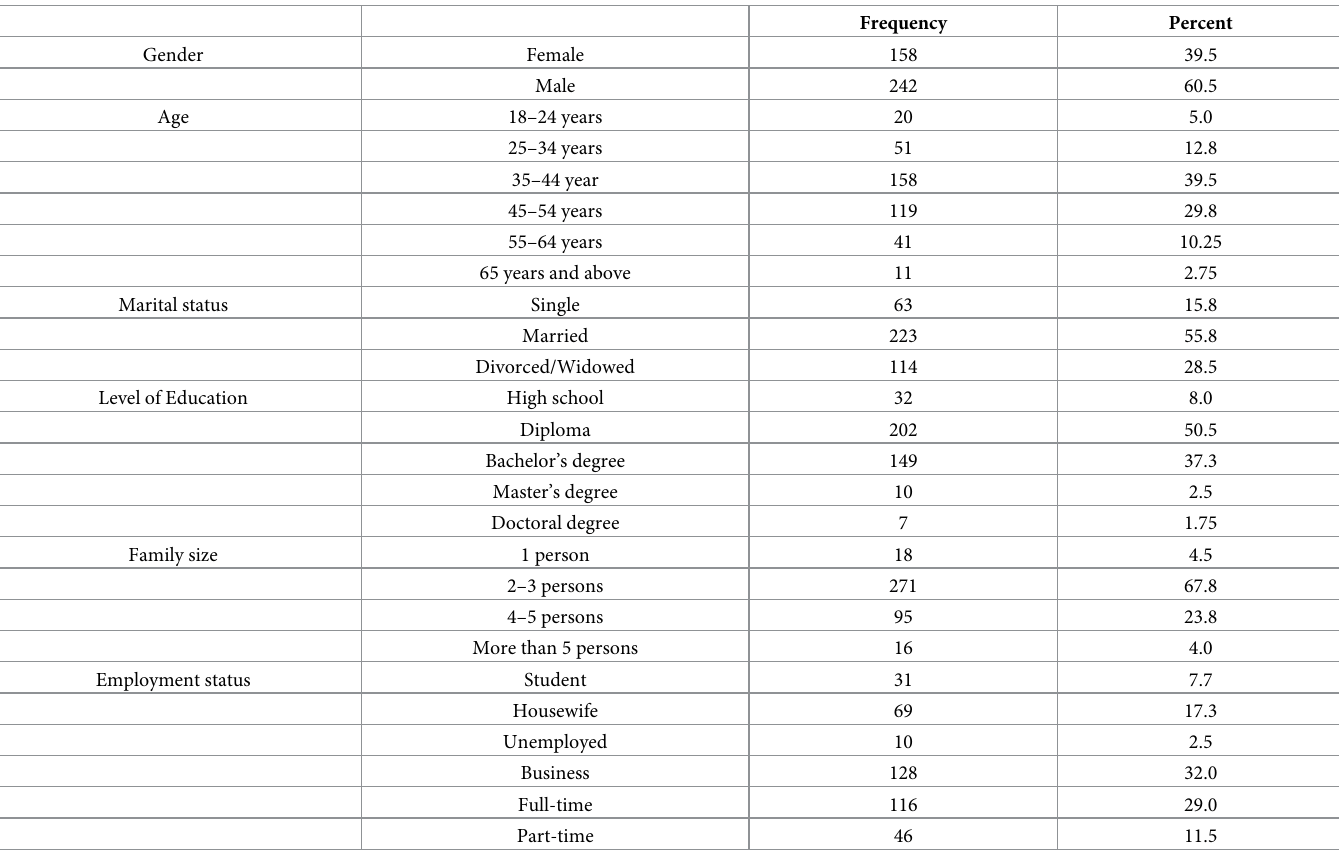
Table 1. Respondents’ demographic